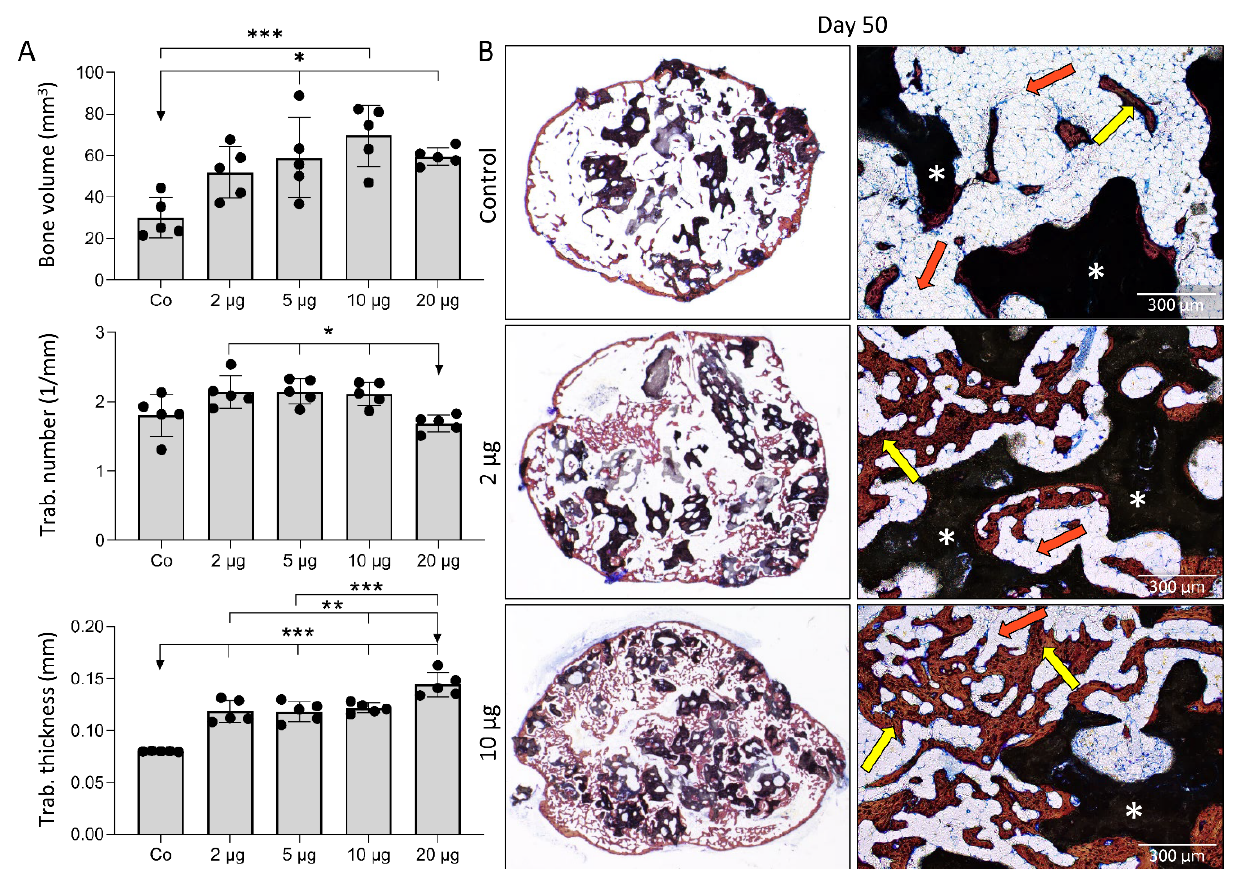
Figure 3. Different doses of ZOL increased bone volume and affected bone microarchitecture 50 days following subcutaneous implantation of ABGS (rhBMP6/ABC) implants with ceramics. ( A ) Bone volume (mm 3 ), trabecular number (1/mm), and trabecular thickness (mm) among experimental groups. ( B ) Histological sections (Sanderson’s Rapid Bone Stain with Van Gieson picrofuchsin) through BCS induced by control and implants containing ZOL. Newly formed bone is marked with yellow arrows, while bone marrow is indicated with orange arrows. White asterisks indicate ceramic particles. Scale bars are shown in the lower right corner. All P values below 0.05 were considered significant and are marked with asterisks as follows: * ( p ≤ 0.05), ** ( p ≤ 0.01), *** ( p ≤ 0.001).